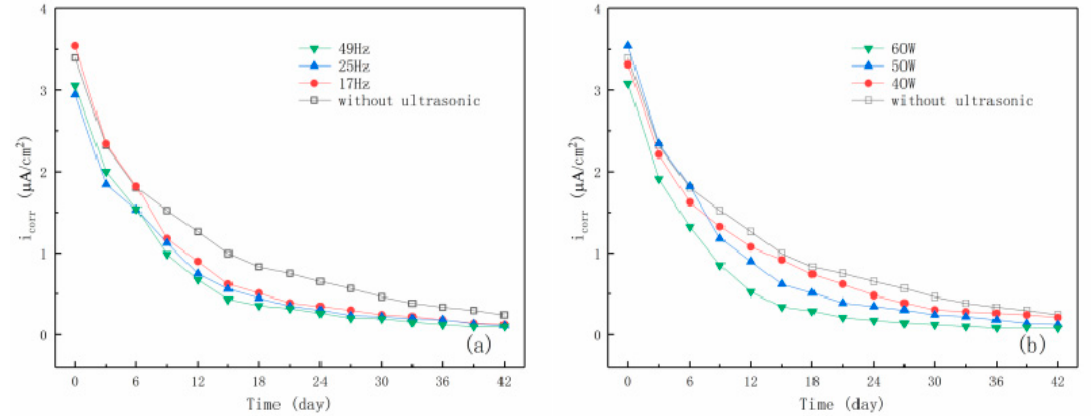
Figure 9. The curves of current density of steel bar in desalting specimens with time. ( a ) Di ff erent ultrasound frequencies; ( b ) di ff erent ultrasound